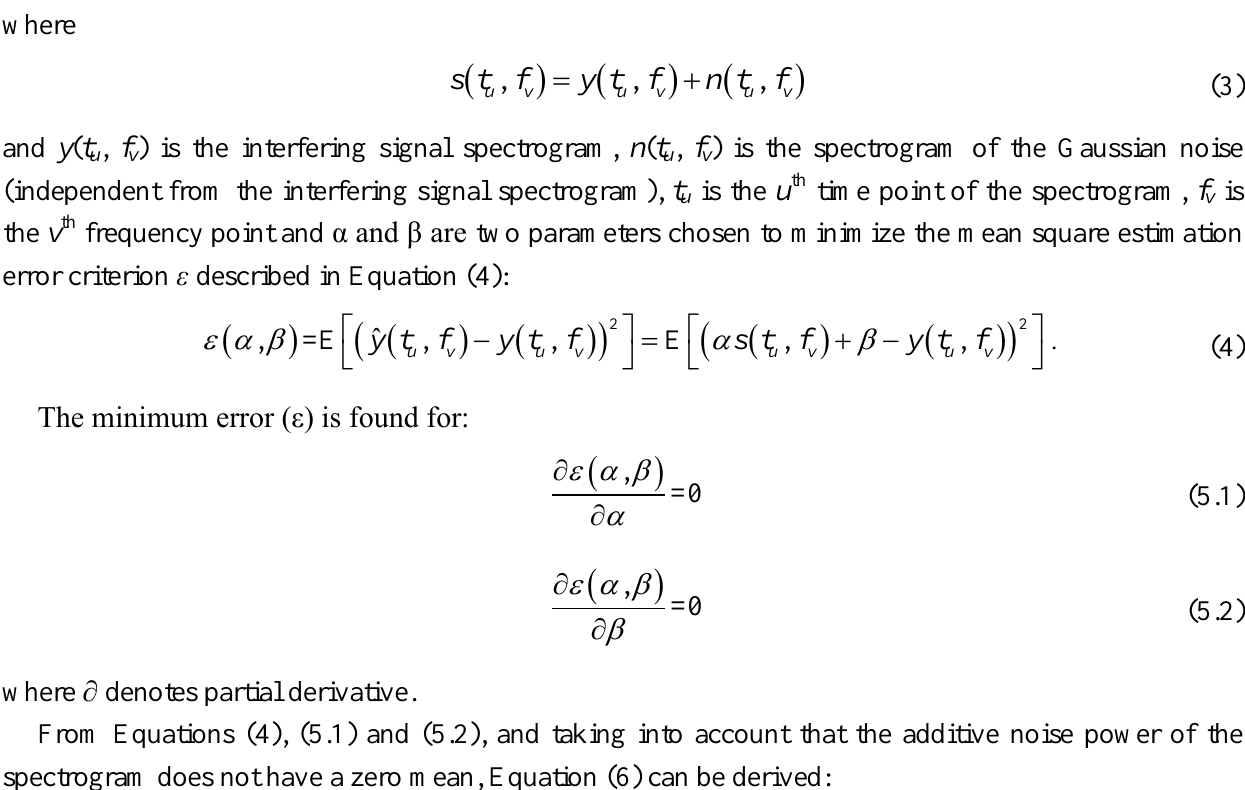
, f ) of the RFI signal spectrogram is u v